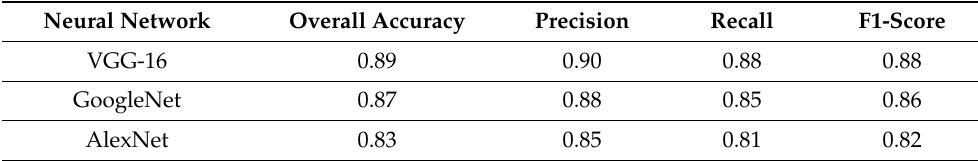
Table 5. CNNs models performance results for weeds clasfication in real time field experiment.